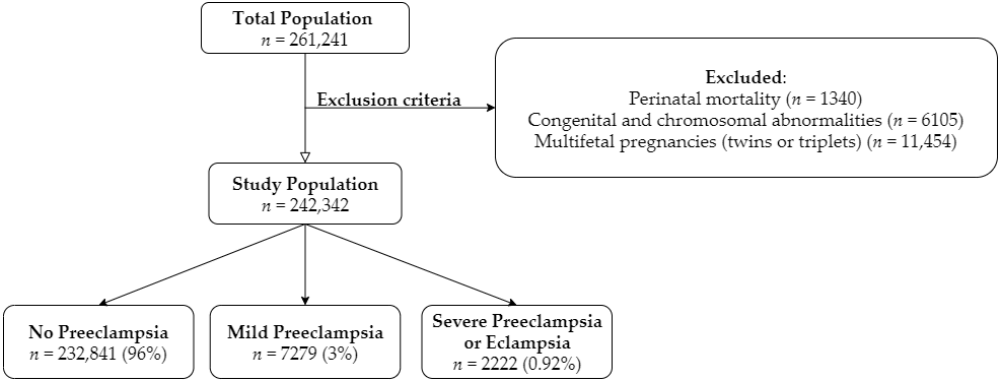
Figure 1. Presents the flowchart for study selection. Table 1. Clinical characteristics of the study population by exposure to maternal preeclampsia. Maternal and Newborn